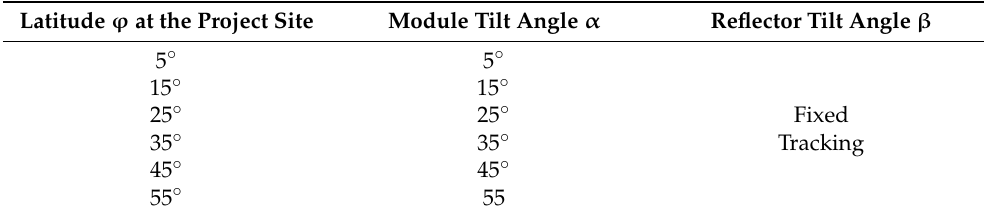
Table 2. Parameters for different working